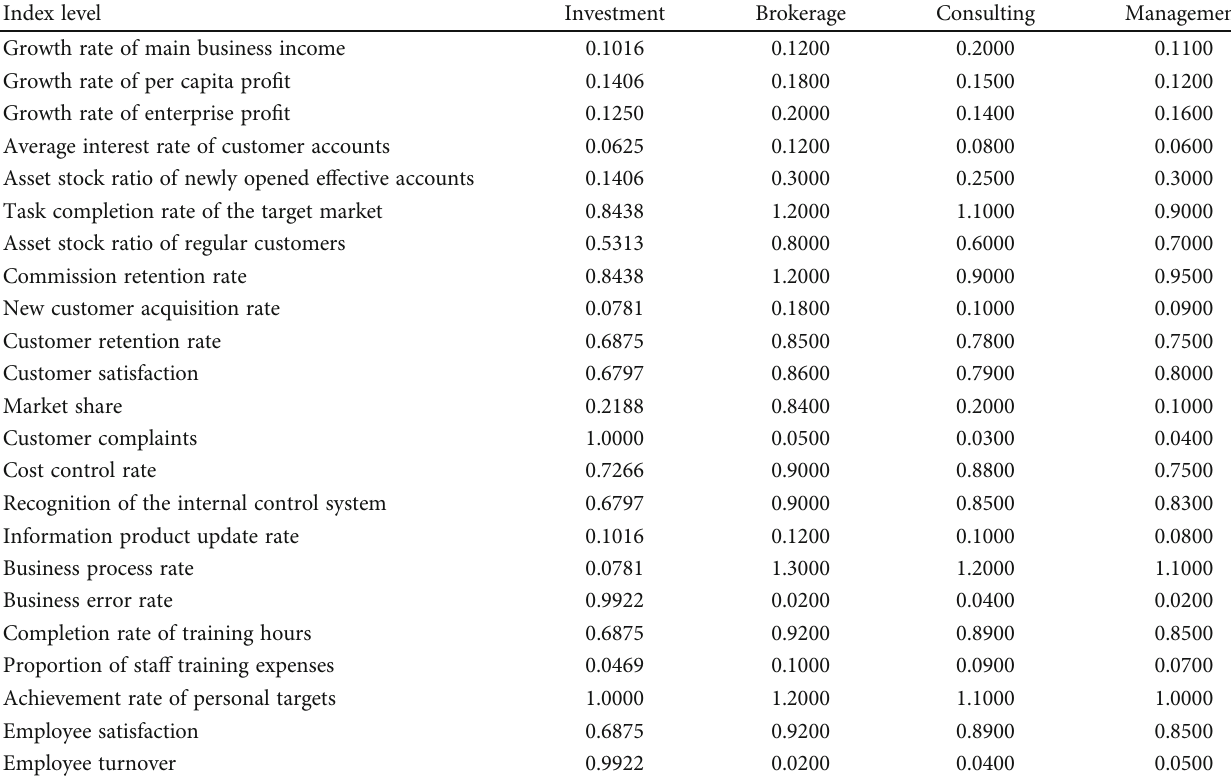
Table 3: Standardization of survey data for BSC-based performance evaluation of securities